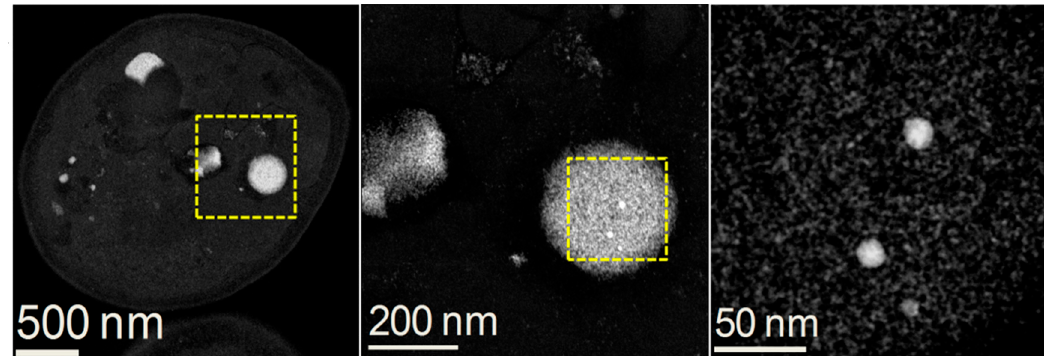
Figure 6. Ultrathin section’s TEM–high-angle annular dark field (TEM–HAADF) analysis of representative Cd–Hg exposed Candida . Zooming into the bright material inside the cell revealed their nanometric nature. Dark field of the highest magnification is shown.